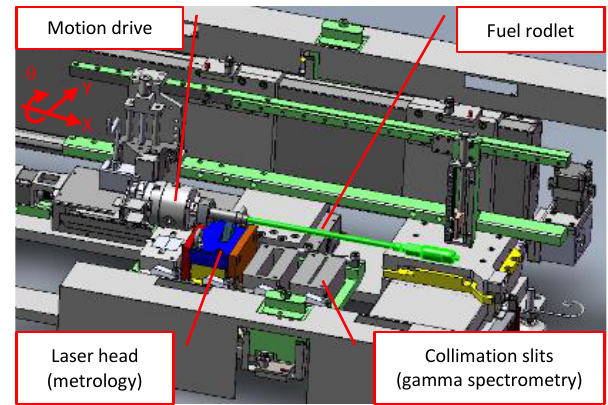
Fig. 5. 3D examination bench for gamma scanning, gamma emission tomography and laser